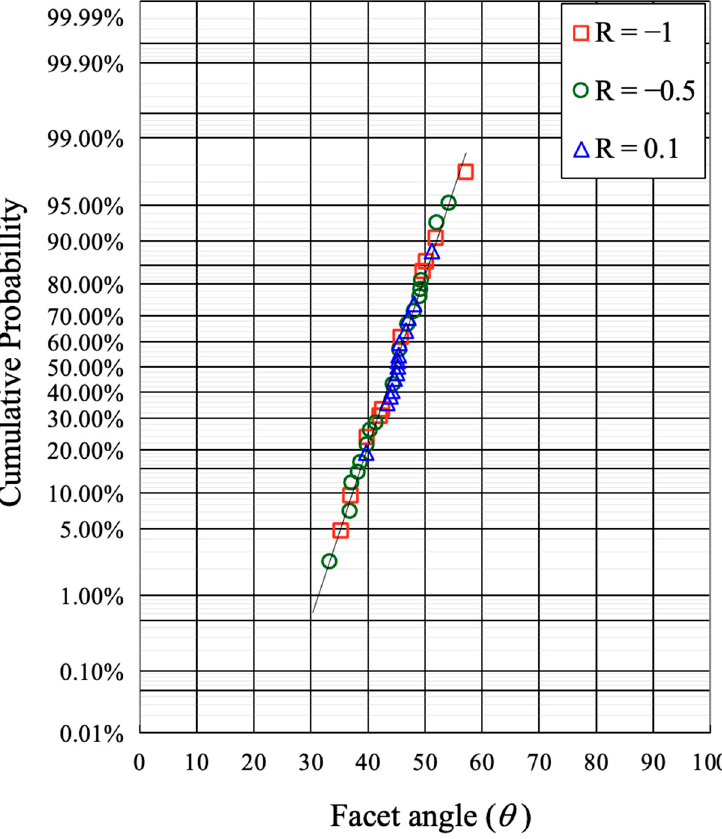
Figure 5. Facet angles plotted on a probability paper of normal distribution.